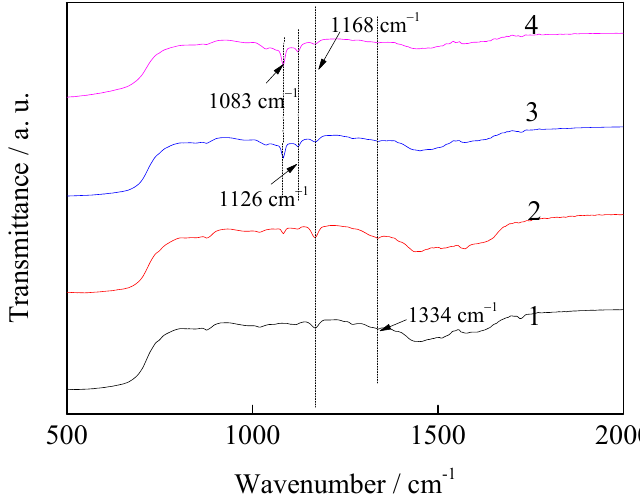
Figure 2. Infrared spectra of magnesite modified using different ILs ((1) [AEMIM]Br, (2) [APMIM]Br, (3) [AEMIM]BF 4 and (4) [APMIM]BF 4 ).